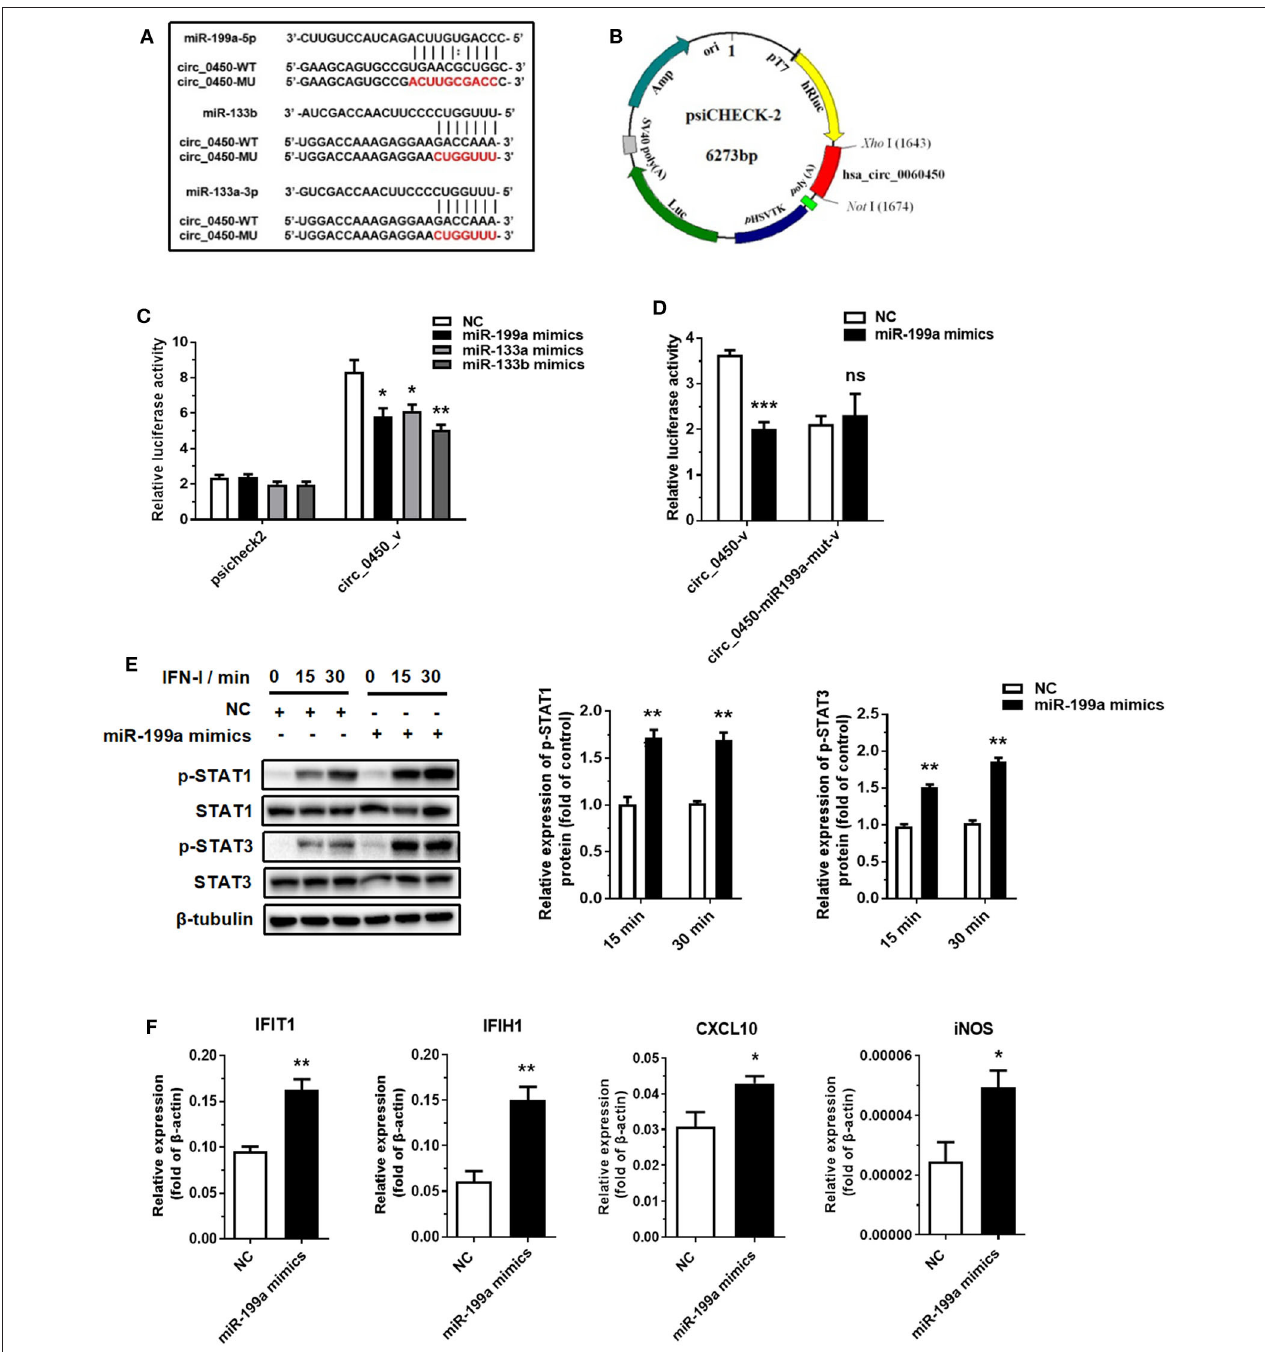
FIGURE 3 | Hsa_circ_0060450 serves as a sponge of miR-199a-5p. (A) The predicted target sequence of miR-199a-5p, miR-133a or miR-133b in hsa_circ_0060450 and corresponding mutant target sequence for binding sites-mutant luciferase assay. (B) The construction of hsa_circ_0060450 fragment-containing psicheck2 luciferase vector. (C) A luciferase reporter assay was used to detect the luciferase activity of 293T cells co-transfected with blank psicheck2 vector or psicheck2 recombinant vector containing hsa_circ_0060450 fragment and miR-199a-5p, miR-133a, miR-133b mimics, or NC. (D) A luciferase reporter assay was used to detect the luciferase activity of 293T cells co-transfected with psicheck2 recombinant vector containing mutant hsa_circ_0060450 fragment and miR-199a-5p or NC. (E) STAT1 and STAT3 protein phosphorylation assessment and quantification analyses at 15 and 30min of IFN-I stimulation after treatment with miR-199a-5p mimics. (F) RT-qPCR analyses of IFIT1 , IFIH1 , CXCL10 , and iNOS under IFN-I stimulation after treatment with miR-199a-5p mimics. NC, negative control. circ_0450-v, psicheck2 recombinant vector containing WT hsa_circ_0060450 fragment. circ_0450-miR199a-mut-v, psicheck2 recombinant vector containing miR-199a-5p binding site-mutant hsa_circ_0060450 fragment. Data represent means ± SEM. * p < 0.05, ** p < 0.01, *** p < 0.001. ns, not significance.